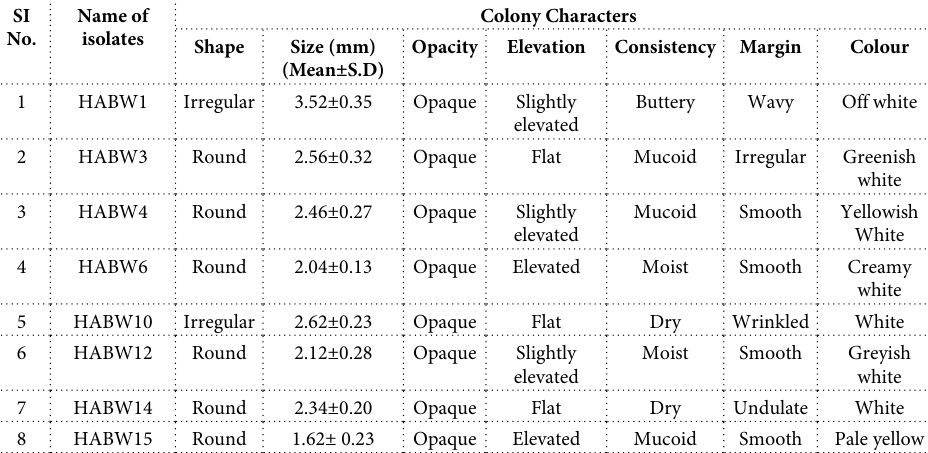
Table 5. Colony characteristics of common bacterial isolates from breeding habitats of Anopheles subpictus mosquitoes. SI No.